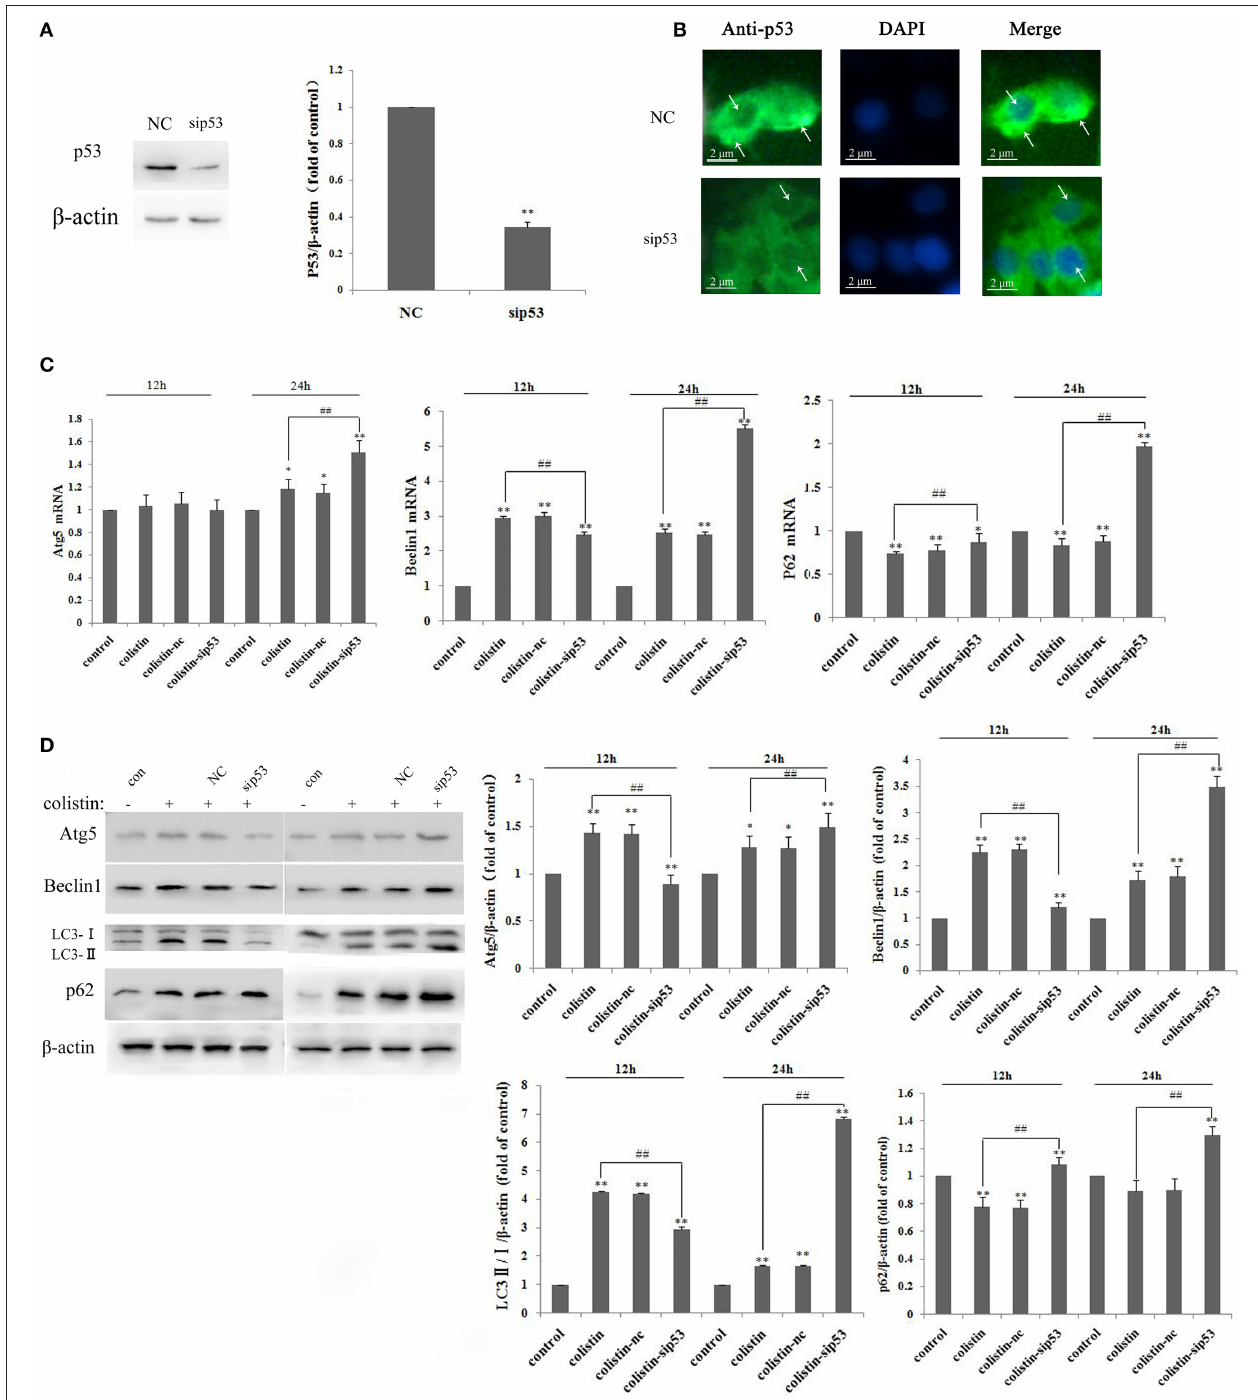
FIGURE 1 | P53-induced impaired autophagy in PC-12-sip53 cells after colistin treatment. (A) Western blot assaying on the levels of p53. Quantification of the protein levels following transfection with siRNA-p53, ** p < 0.01 vs. control group. Bar graph represents the mean percentage ± SD of autophagy cells ( n = 3). ** p < 0.01 vs. control group; ## p < 0.01 vs. inter-groups. (B) The p53 level was decreased in PC-12 cells transfected with sip53 at 48h, and its localization was determined by immunofluorescence staining with a p53 antibody (green) and DAPI staining (blue). Arrows indicate p53 punctum. (C) The expression levels of autophagy-related genes, including Atg5, beclin1, and p62 were determined by RT-PCR following 125 µ g/mL colistin treatment for 12 and 24h. Bar graph represents the mean percentage ± SD of autophagy cells ( n = 3). * p < 0.05 vs. control group, ** p < 0.01 vs. inter-groups; * p < 0.05 vs. control group, ## p < 0.01 vs. inter-groups. (D) Western blot assaying on the levels of Atg5, beclin1, p62, and the ratio of LC3-II/I. The β -actin level was used as the internal standard. Bar graph represents the mean percentage ± SD , whereas n = 3. ** p < 0.01 vs. control group.